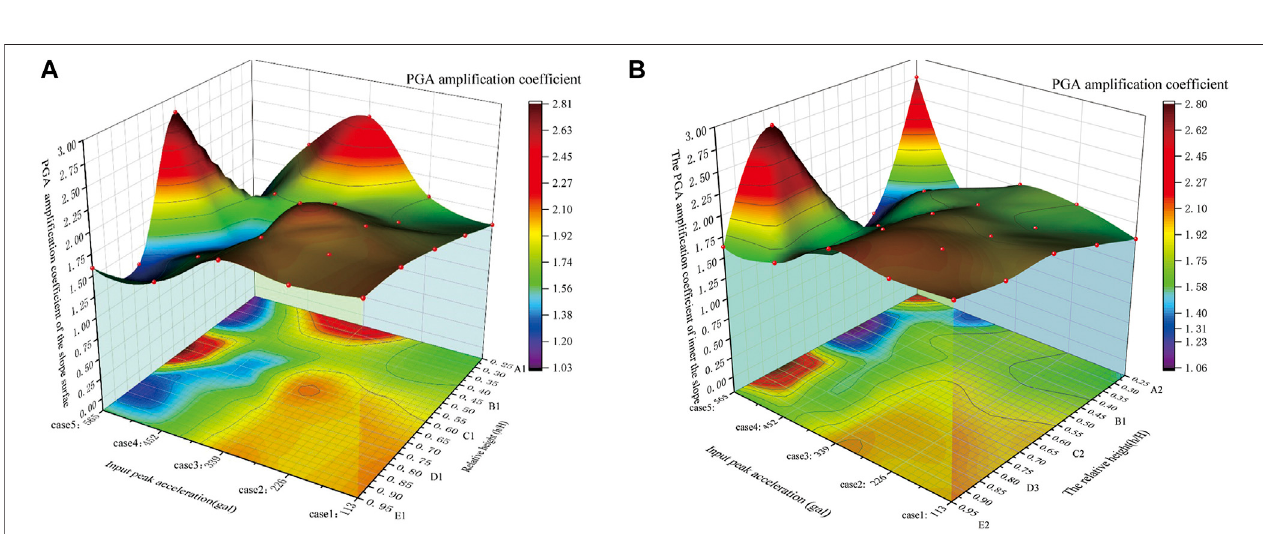
Frontiers in Earth Science |